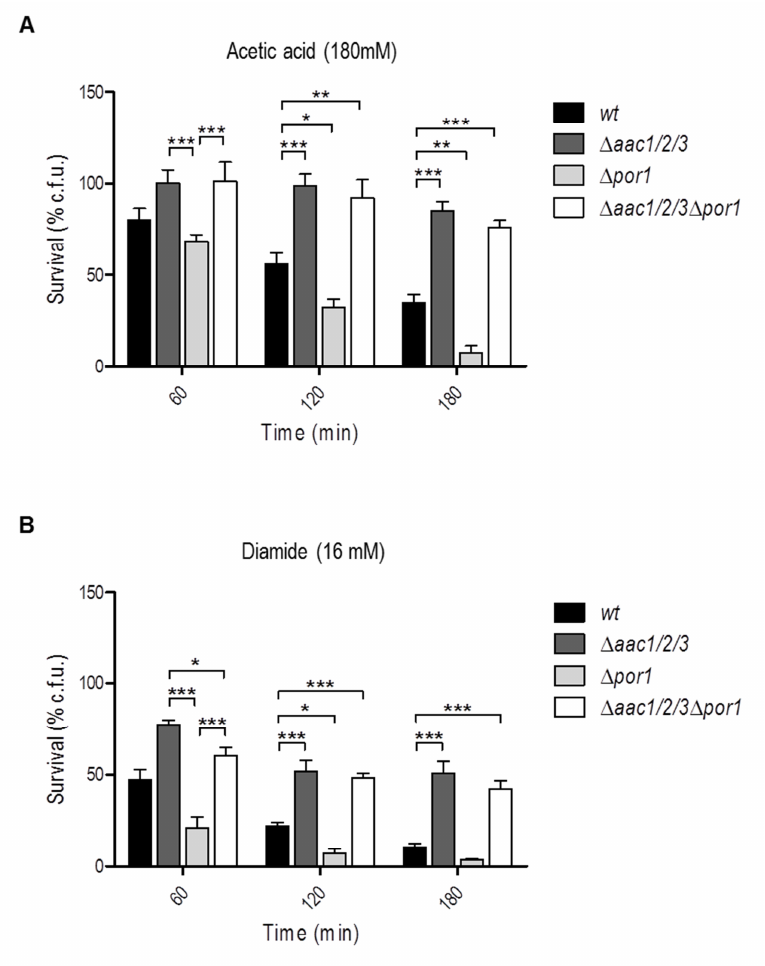
FIGURE 1: Absence of the AAC proteins promotes survival of S. cerevisiae to acetic acid and dia- mide reverting the sensitivity phenotype of Δ por1 cells. (A) Survival of wt , Δ aac1/2/3 , Δ por1 and Δ aac1/2/3 Δ por1 cells after treatment with acetic acid (180 mM) was determined by c.f.u. counts after 60, 120 and 180 minutes of treat- ment, considering the total c.f.u. number at T0 as 100 % survival. (B) Survival of wt , Δ aac1/2/3 , Δ por1 and Δ aac1/2/3 Δ por1 cells after treatment with diamide (16 mM) was determined by c.f.u.